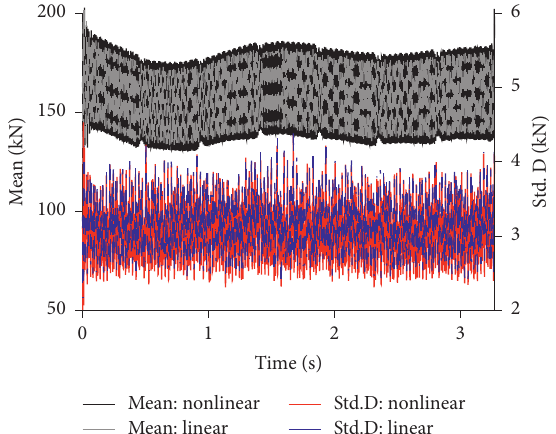
Figure 8: Vertical contact force of first wheelset (double side).